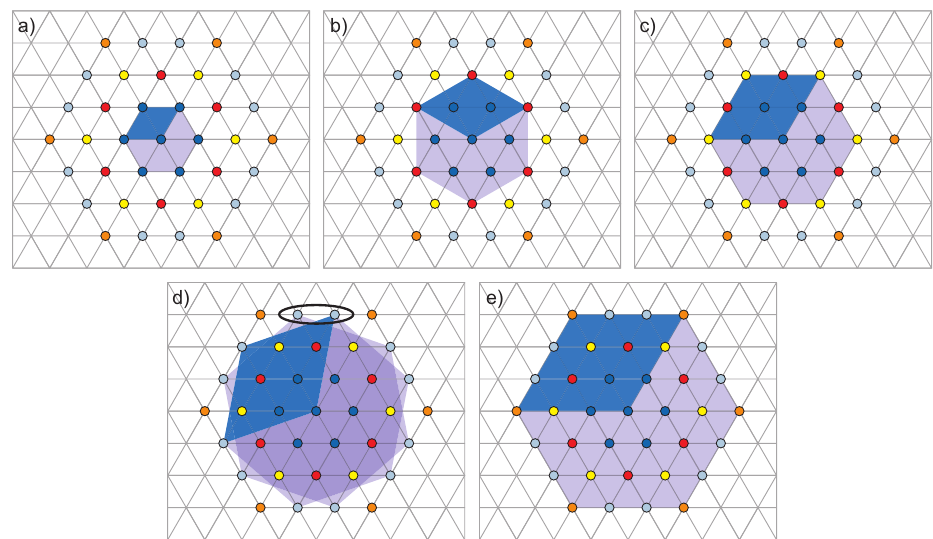
Figure A2. Triangle Wigner 2D lattice created by nearest ( a ) and next-nearest neighbors ( b – e ) up to 4-th order with a visualized elementary Bravais cells with a growing surface for selected neighbor sublattices.